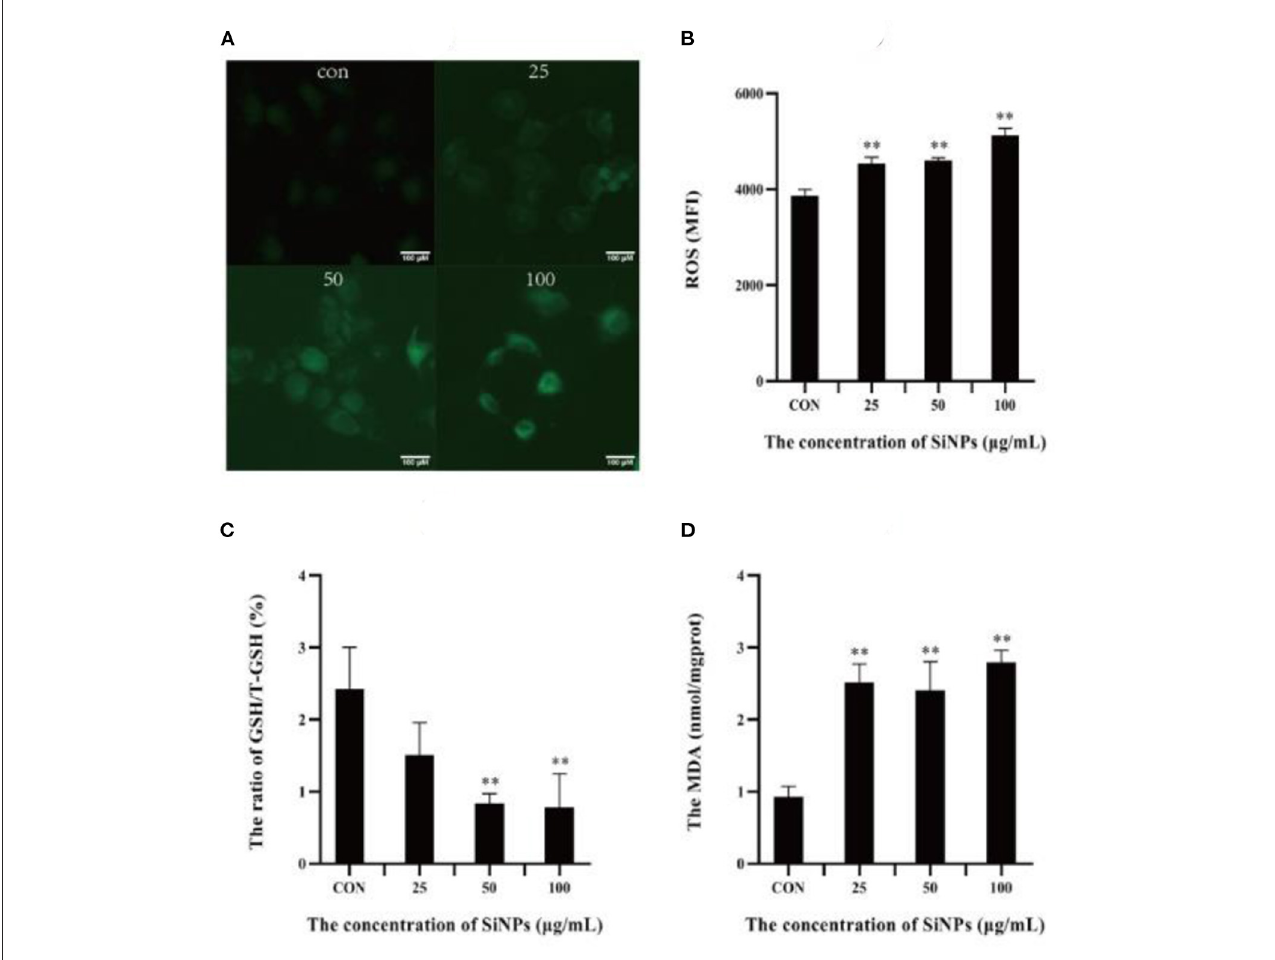
FIGURE3 The levels of ROS, MDA and ratios of GSH/T-GSH in HUVECs. (A) The intensity of intracellular green fluorescence. (B) The relative levels of intracellular ROS. (C) The ratio of GSH/total GSH. (D) The levels of MDA. [** p < 0.01, compared with the con, n =